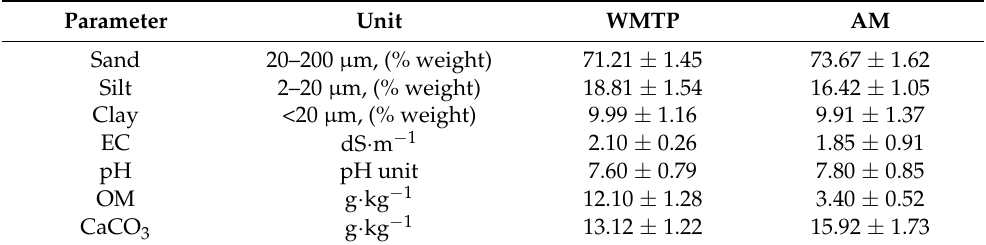
Table 1. Soil physicochemical properties at both Wadi-Musa Wastewater Treatment Plant (WMTP) and Ain Mousa (AM) experimental sites. The data are averages ± SD ( n =